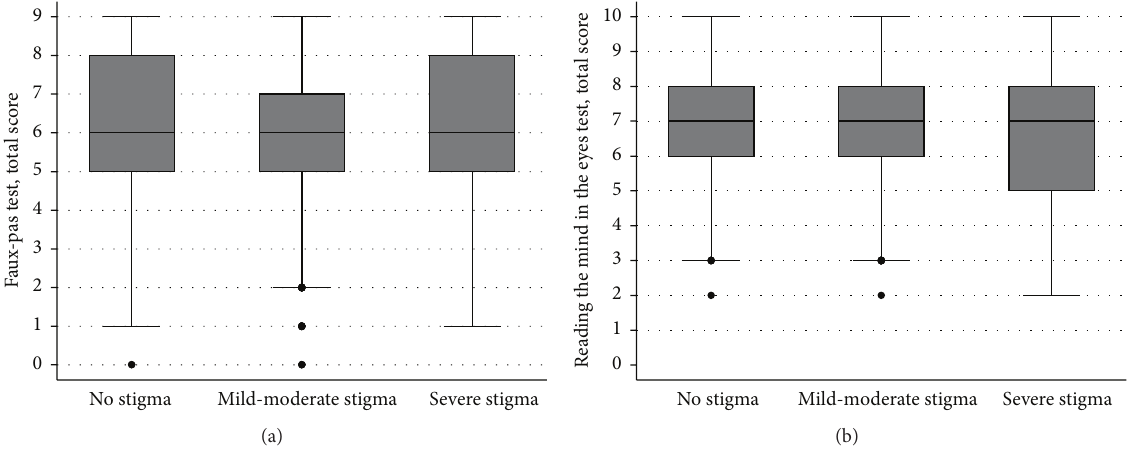
Figure 1: Box plots representing the score profile for participants on the Theory of Mind tests according to the extent of felt stigma they reported. (a) shows scores on the Faux Pas Test; (b) shows scores on the Reading the Mind in the Eyes test. Notes: dark horizontal lines represent the median, with the boxes representing the 25th and 75th percentiles, the whiskers the 5th and 95th percentiles, and outliers represented by dots. For the Faux Pas Test, the data relates to only those participants who did not fail any comprehension control